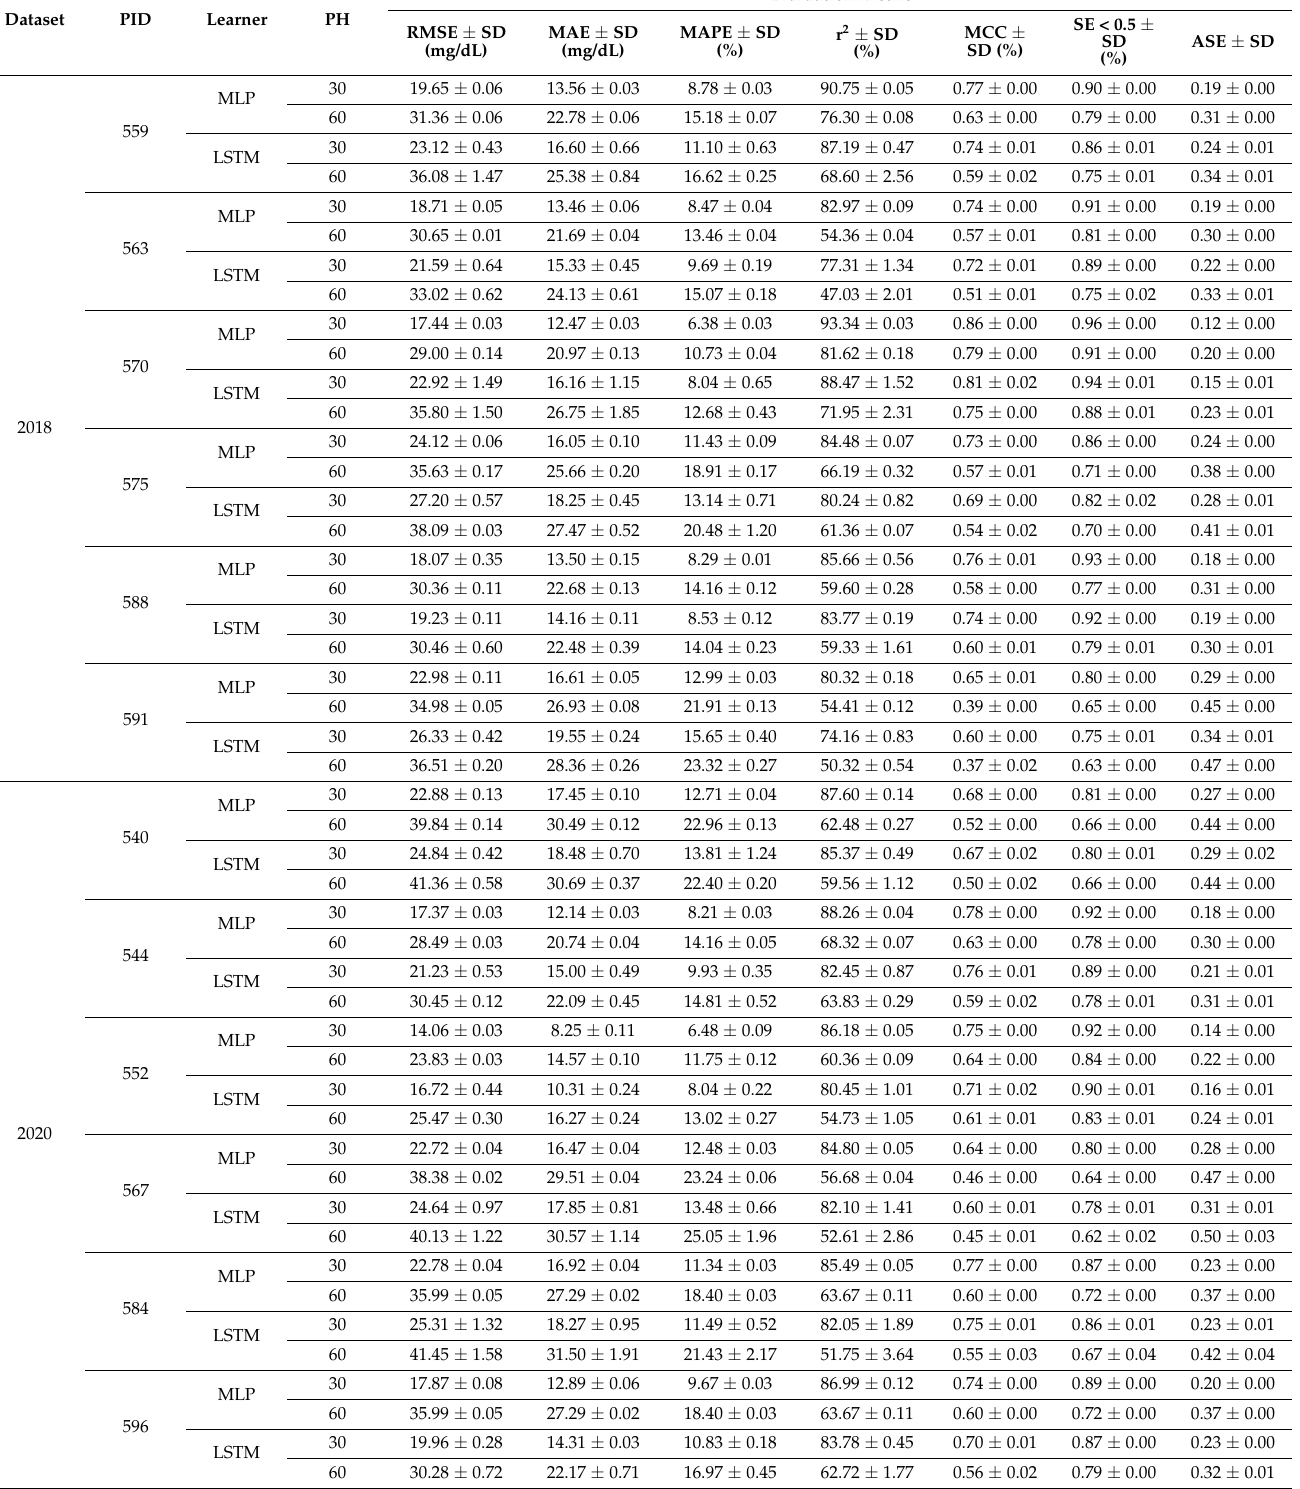
Table 2. The evaluation results for the best non-stacking models created using Ohio